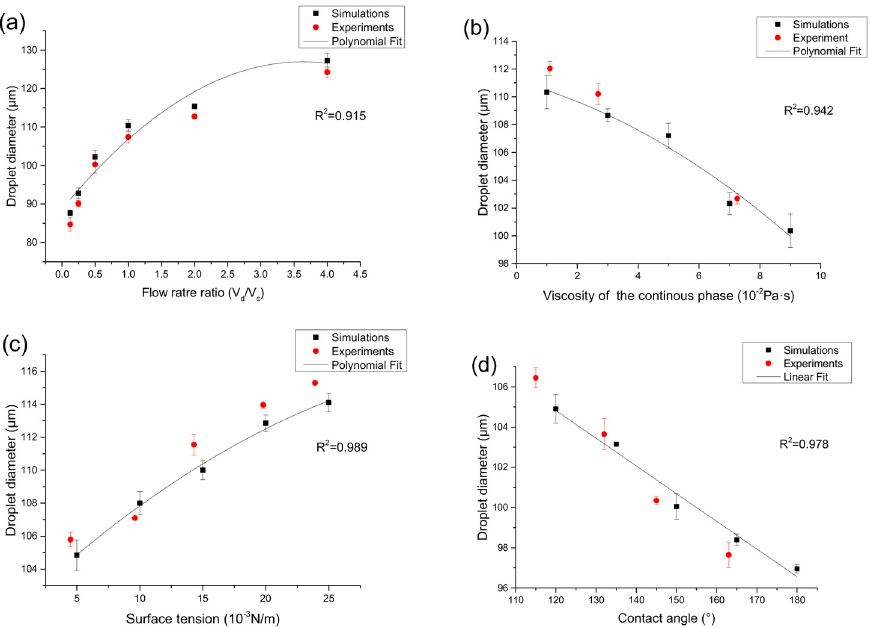
Figure 6. Comparison of simulation droplet diameter with experimental observations under different continuous phase flow rate ratio ( a ), viscosity ( b ), surface tension ( c ), and contact angle ( d ).